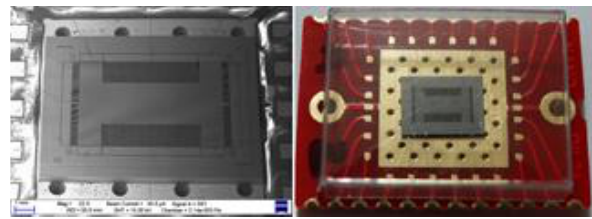
Figure 11. SEM image and photograph of the MEMS sensing ele-